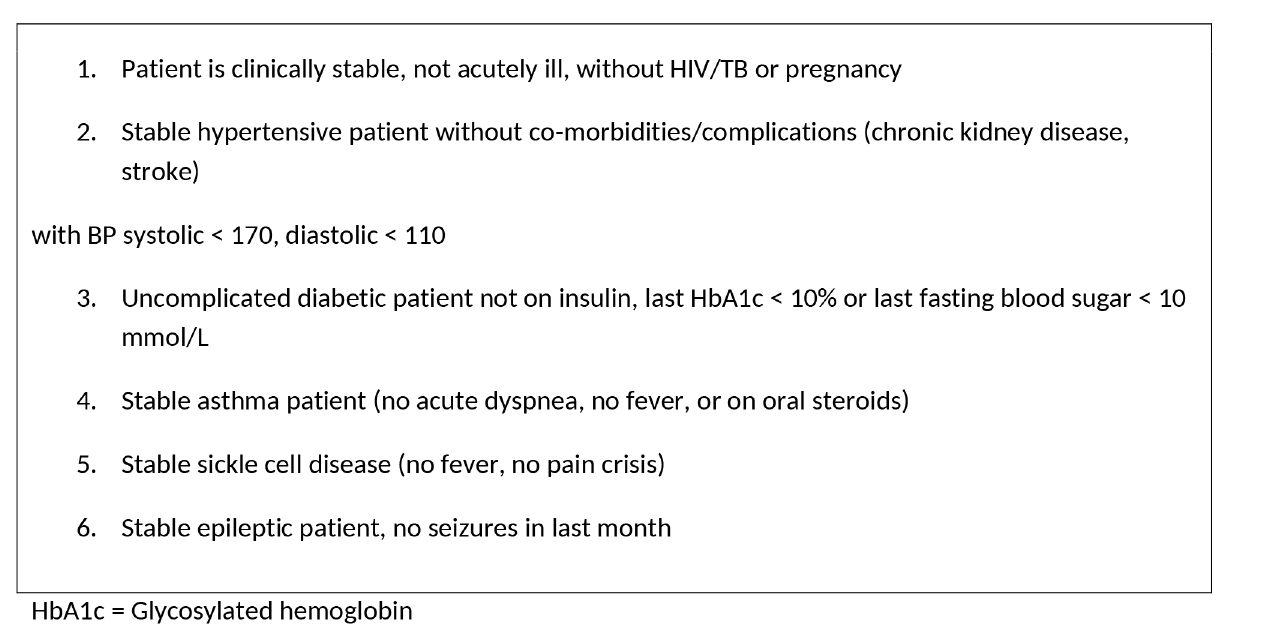
PLOS ONE | DOI:10.1371/journal.pone.0145634 January 26,